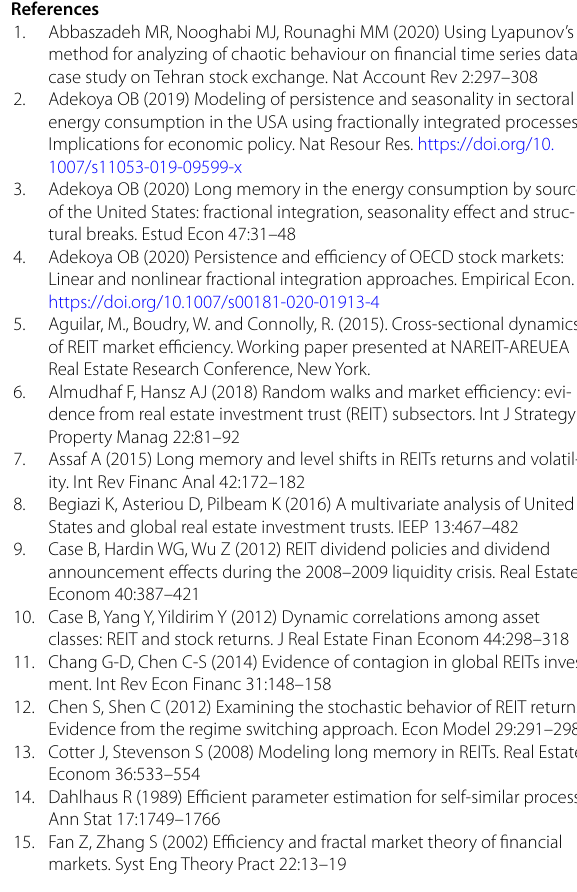
w and T are the bandwidth number and the total number of observations, respectively. Values in bold are those cases where the d estimates are significantly lower than